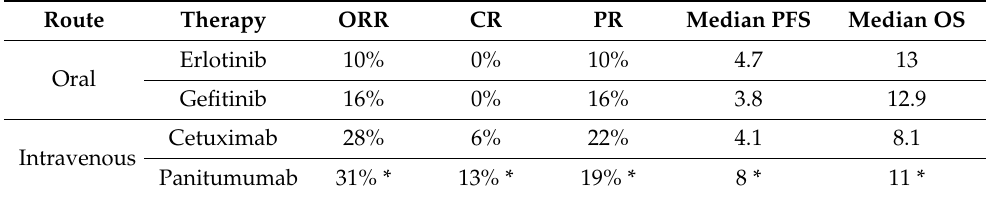
Table 6. Prospective study summaries for targeted therapy of cutaneous squamous cell carcinoma; ORR, objective response rate; CR, complete response; PR, partial response; PFS, progression free survival (in months); OS, overall survival (in months). * All patients treated as second